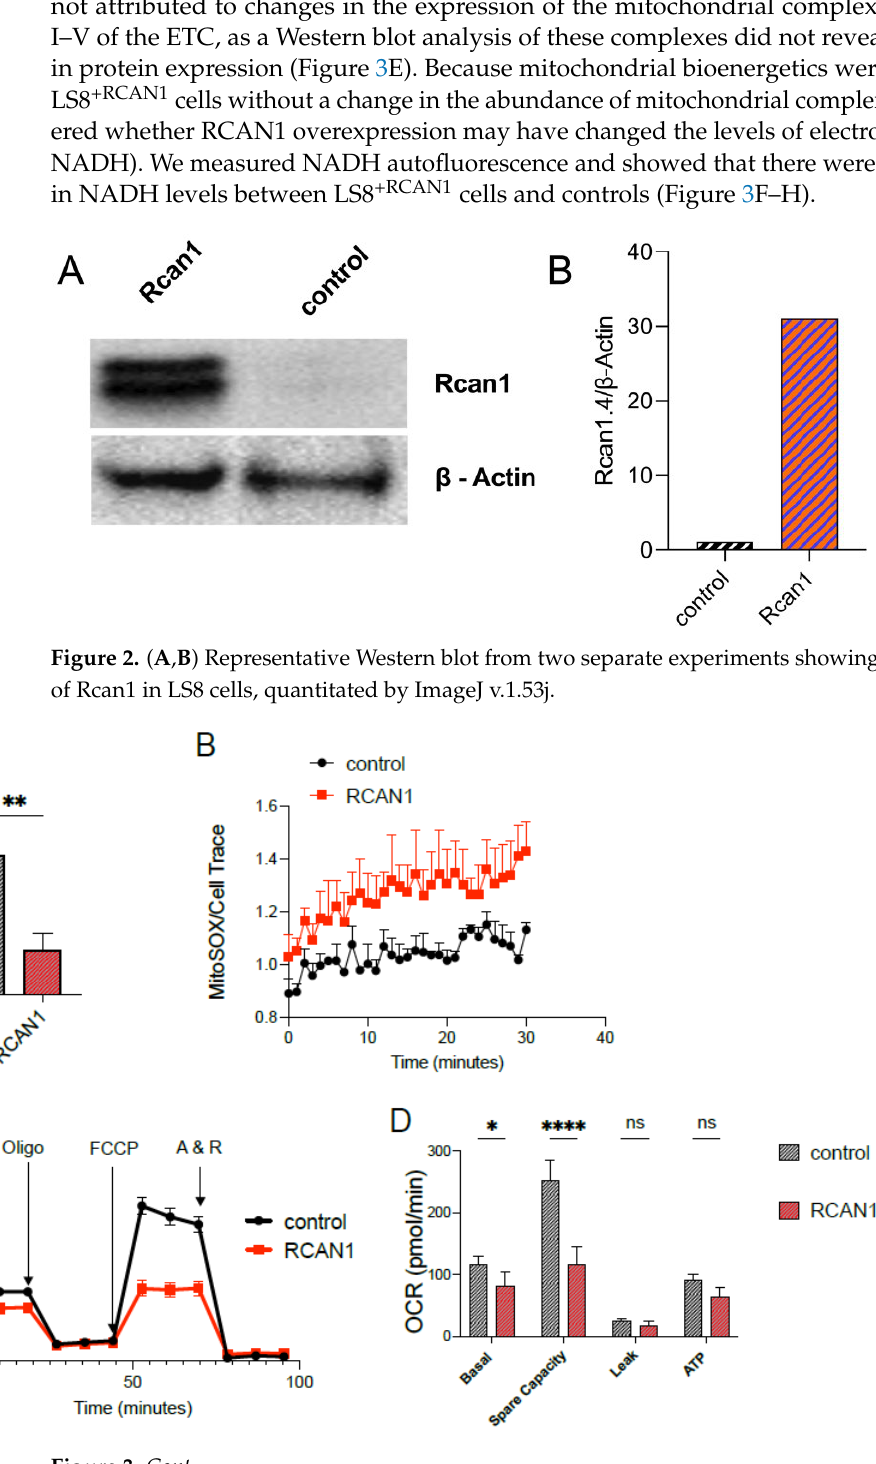
Figure 3. ( A ) Quantification of the reduced (GSH) to oxidized (GSSG) glutathione in LS8 overex- pressing Rcan1. ( B ) Traces of MitoSOX measurements in control and Rcan1 overexpressing LS8 cells. ( C ) Oxygen consumption rate (OCR) measured in control and RCAN1 overexpressing LS8 cells. ( D ) Quantification of basal respiration, spare respiratory capacity, proton leak, and ATP- linked mitochondrial respiration. ( E ) Western blot showing the expression of the mitochondrial complex proteins I–IV and the ATP synthase in control and RCAN1 overexpressing LS8 cells. ( F – H ) NADH autofluorescence in control ( F ) and RCAN1 overexpressing ( G ) LS8 cells. ( H ) Quantification of the redox state. Data represent the mean ± SEM of three independent experiments analyzed by Student’s t -test. * p < 0.05, ** p < 0.01, **** p < 0.0001. 3.3. RCAN1 Overexpression Elevated Mitochondrial Ca 2+ Uptake We then investigated whether Ca 2+ signaling was a possible contributor to changes in mitochondrial function in the LS8 +RCAN1 cells because the activity of several Ca 2+ -de- pendent tricarboxylic acid (TCA) cycle enzymes is enhanced by mitochondrial Ca 2+ [24]. We measured Ca 2+ uptake in the mitochondria of LS8 +RCAN1 cells and controls after ATP (100 μM) stimulation in the presence of external Ca 2+ in the solution to induce IP 3 R-medi- ated Ca 2+ release from the endoplasmic reticulum (ER). Enamel cells express all three IP 3 R subtypes [25], and they respond to stimulation by ATP [18]. ATP stimulation of LS8 +RCAN1 cells loaded with the mitochondrial Ca 2+ indicator Rhod-2AM showed significantly higher mitochondrial Ca 2+ uptake than controls (Figure 4A–C).